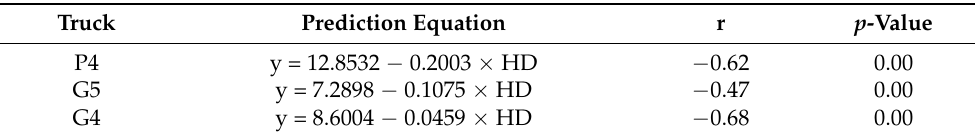
Table 4. Outcomes of the regression and correlation analysis between hourly productivity (y; m 3 × h − 1 ) and haulage distance (HD; km).